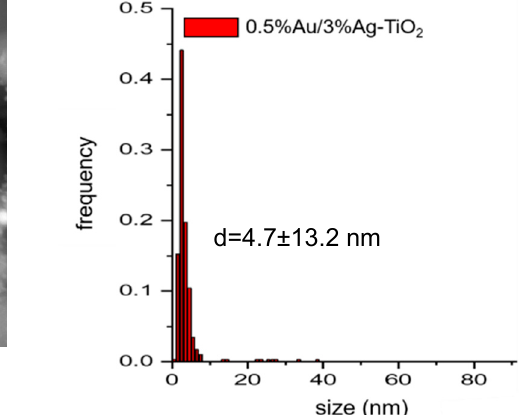
Figure 8. Representative TEM and HAADF images of the 0.5%Au/3%Ag-TiO 2 sample and particle size distribution.